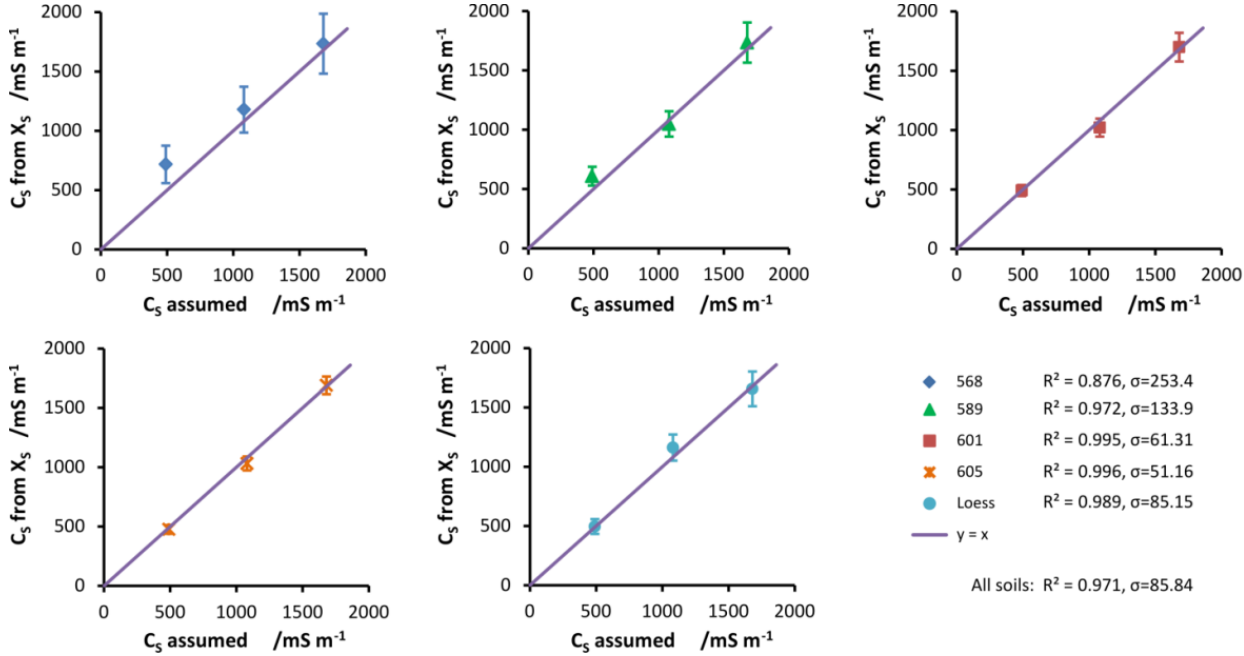
Figure 5. Conductivities of the moistening solutions calculated from the linear salinity index model vs . assumed conductivities for all tested soils. The straight line has a slope equal to 1 and corresponds to the perfect